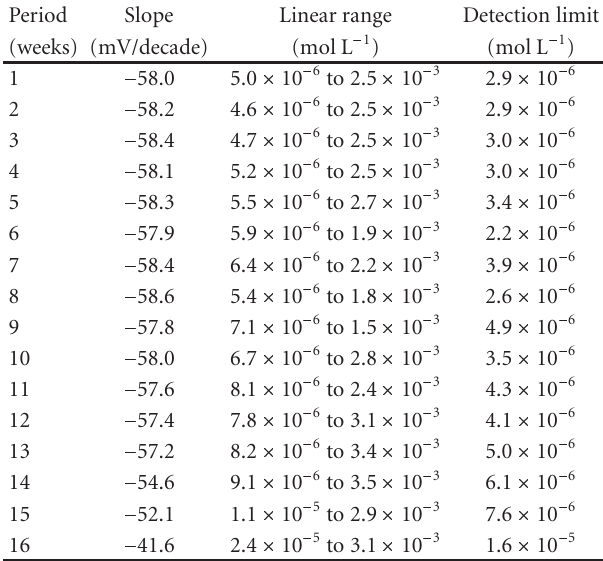
Table 2: The life time study of the anionic surfactant selective electrode.